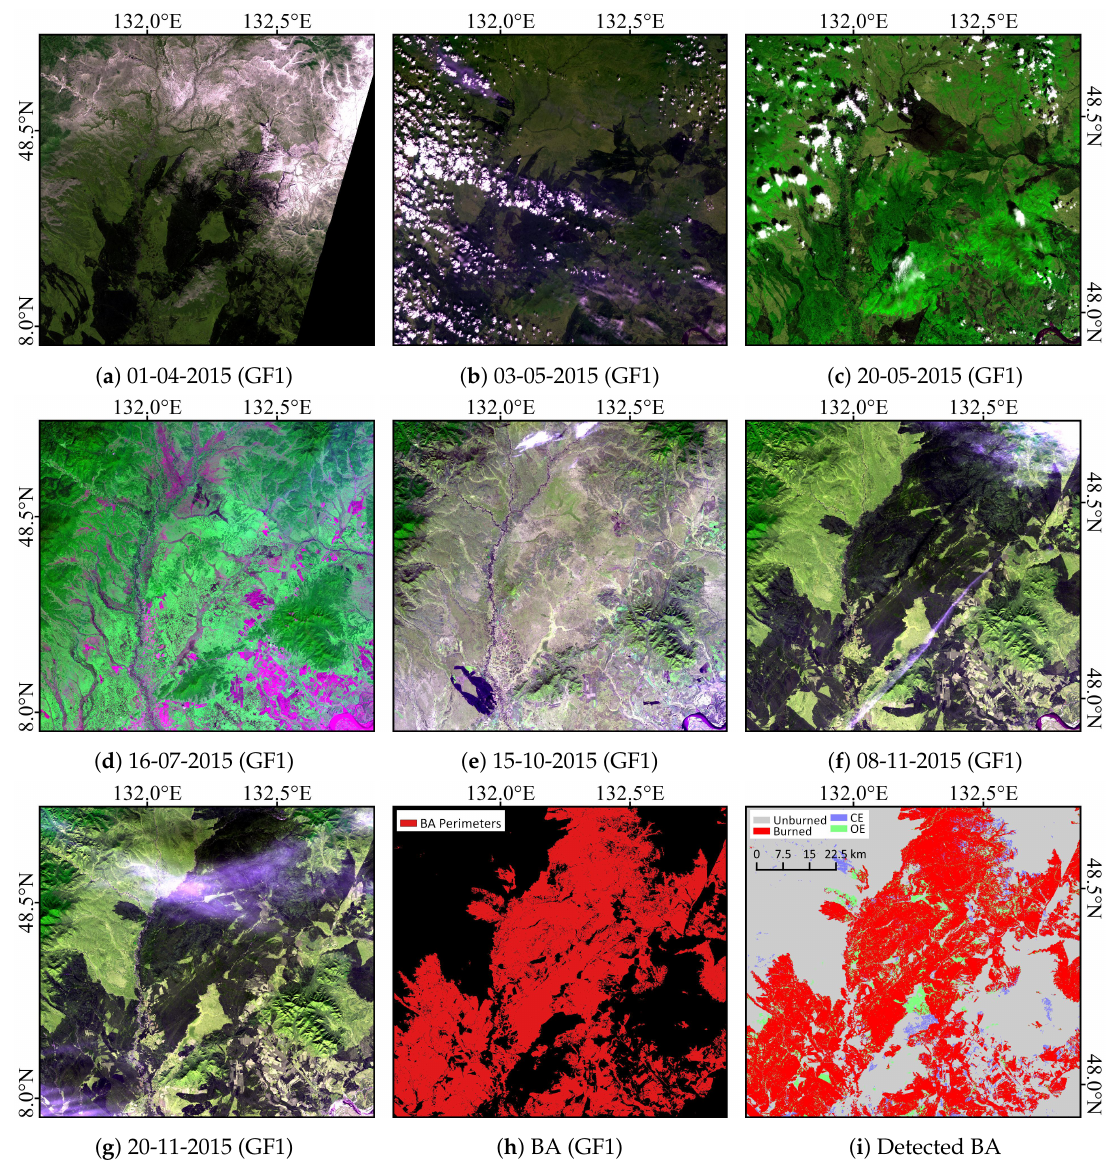
Figure A1. Example of validation using GF-1 images. ( a – g ) show the GF-1 images used to generate the reference map, displayed in false color composition (red: NIR band, green: red band, and blue: green band); ( h ) is the reference BA map generated from GF-1 images; and ( i ) is the detected BA by the proposed method with Commission Error (CE) and Omission Error